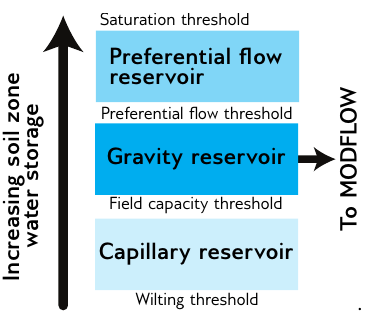
Figure 2. Soil-water storage reservoirs in the PRMS component of GSFLOW. Within each HRU, soil-water accounting calculations are carried out for three conceptual reservoirs in the order of increas- ing water storage and according to user-specified parameters. Cli- mate forcing applies to the capillary reservoir; the gravity reservoir exchanges water with the deeper unsaturated and saturated zones represented by the MODFLOW component of GSFLOW, and Dun- nian runoff and fast interflow occur in the preferential flow reservoir. (Adapted from Markstrom et al., 2008, Fig.